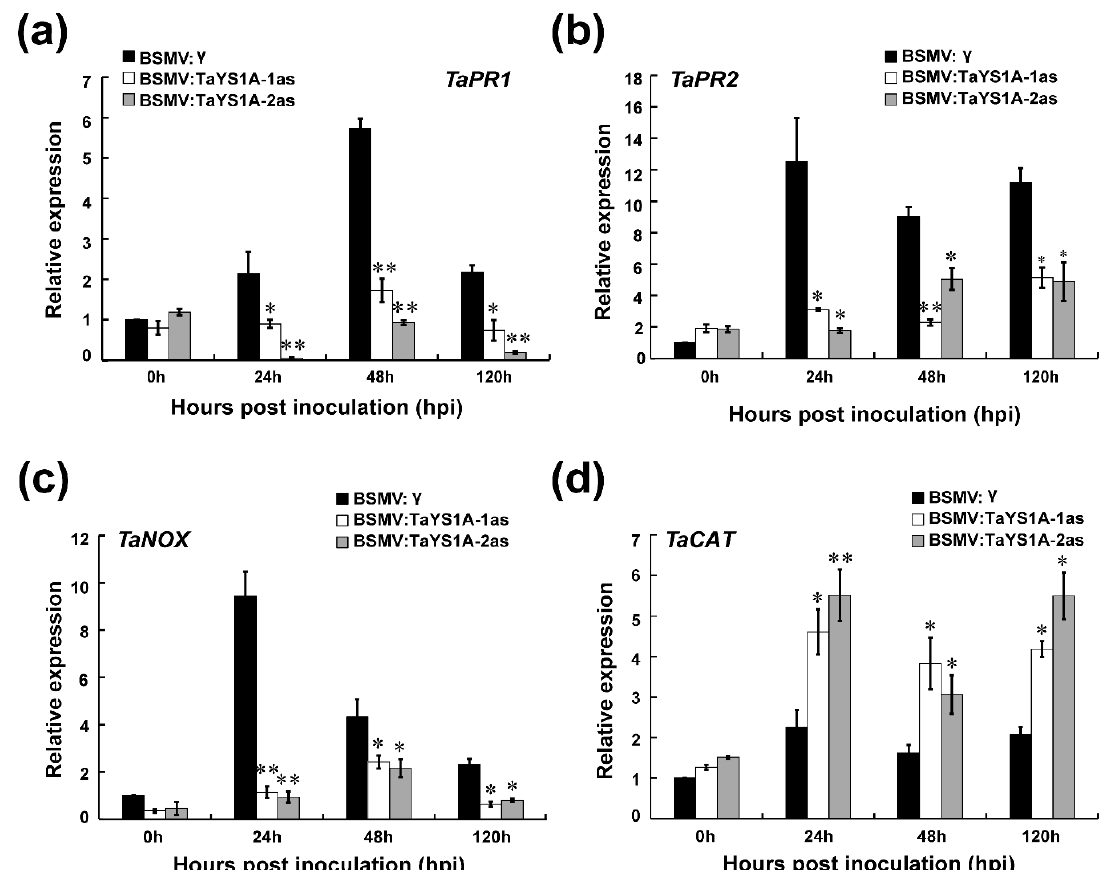
Figure 6. Relative expression of defense and reactive oxygen species (ROS) related marker genes in TaYSIA- silenced plants infected with Pst avirulent race CYR23 ( a ) The relative expression of TaPR1 (pathogenesis-related gene 1). ( b ) The relative expression of TaPR2 ( β -1,3-glucanase). ( c ) The relative expression of TaNOX (NADPH oxidase) ( d ) The relative expression of TaCAT (catalase). The qRT-PCR was used to analyze the relative expression of all genes. The comparative threshold (2 − ∆∆ CT ) approach was used to measure the relative transcript levels of TaYS1A . Data normalized with the transcription of wheat elongation factor, TaEF-1 α , and visualized as fold change compared to control at 0h. BSMV: γ infected wheat leaves were used as a control. Values represent the mean ± standard errors of three independent biological samples. Asterisks ( p < 0.05) or double asterisks ( p < 0.01) designate significant differences from BSMV: γ by the Student’s t -test.